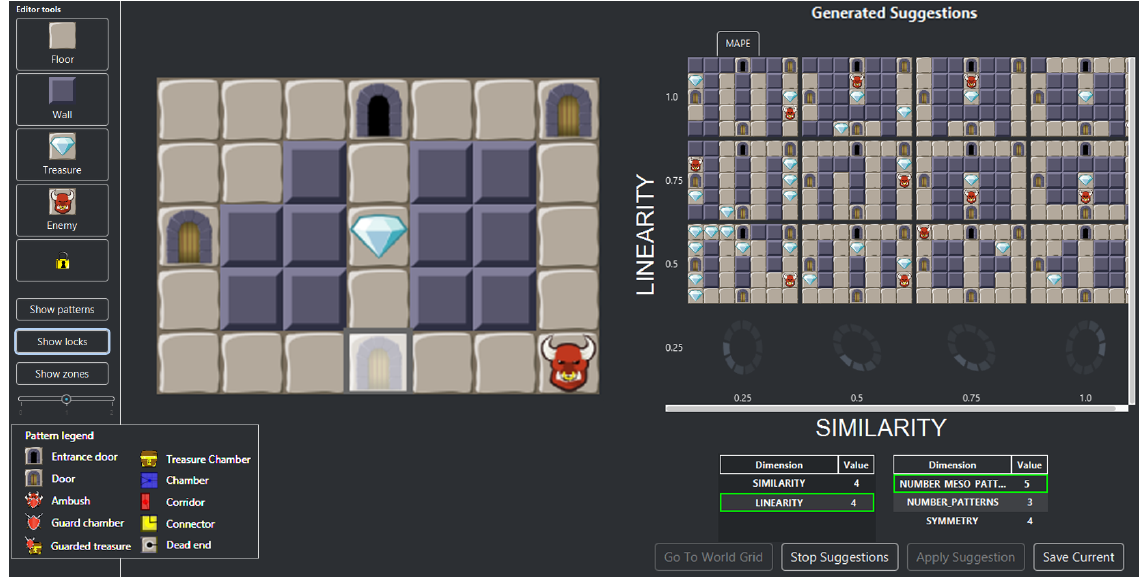
Figure 5. Evolutionary Dungeon Designer by Alvarez et al.